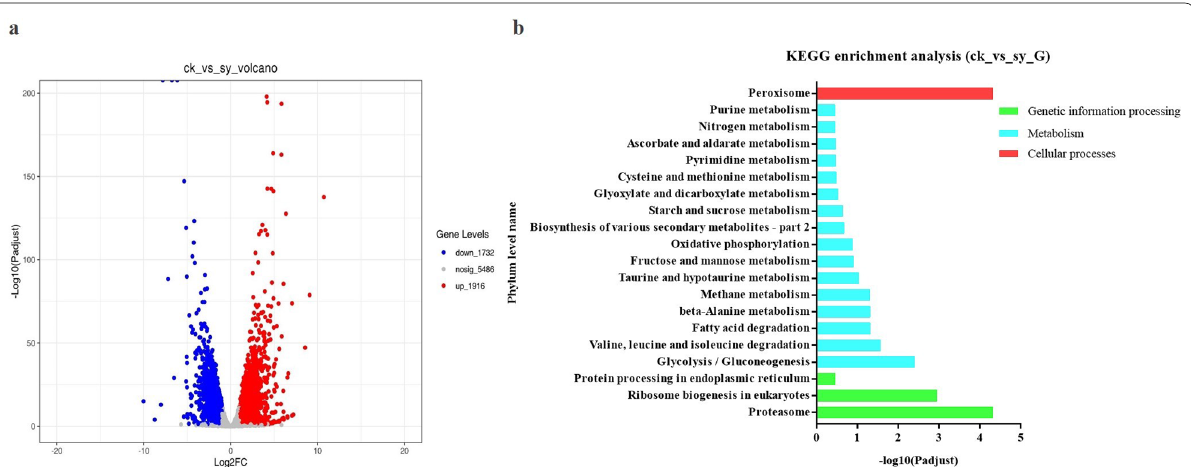
Fig. 1 Differentially expressed genes (DEGs) enrichment analysis in P. digitatum cells under 1.2 g/L X33 AMOP treatment. a Cluster analysis volcano profile of DEGs. b Mostly enriched KEGG pathway of DEGs in P. digitatum . Ck represents the control group treated by water. Sy represents the tested group treated by 1.2 g/L X33 AMOP